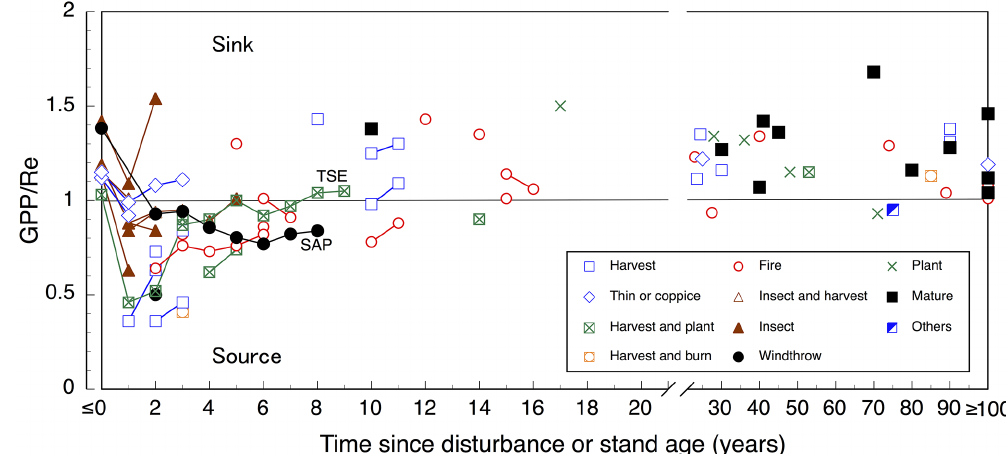
Figure 10. The carbon uptake efficiency (GPP/Re) in forest with years since last disturbance in the forest or stand age for the mature forest. The GPP/Re with years ≤ 0 (data before disturbance) is plotted on the left margin. Similarly, the GPP/Re with years older than or equal to 100 is plotted on the right margin. Data older than 20 years are averaged. In particular, data of the TSE site (Aguilos et al., 2014) and SAP site (the present study) are indicated. At these two sites, the measurements include periods both before and after the disturbance and were taken for over 10